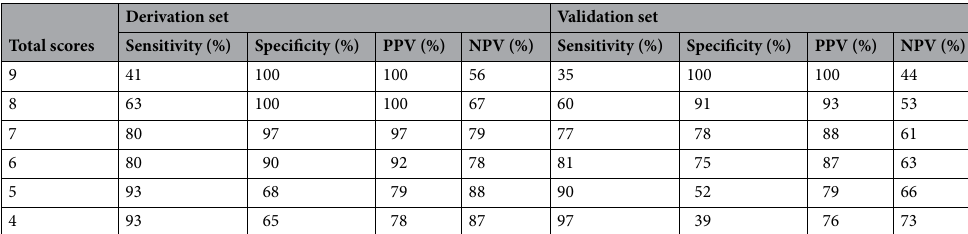
Table 3. RCVS–TCH score performance. PPV positive predictive value, NPV negative predictive value.